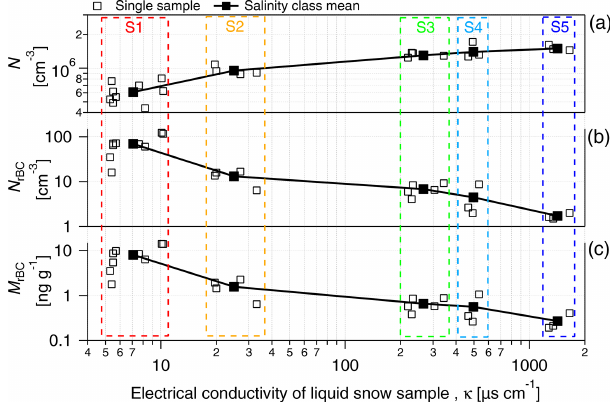
Figure 2. (a) The number concentration of the total particles ( N ), (b) number concentration of rBC particles ( N rBC ) and (c) mass mix- ing ratio ( M rBC ) produced from the nebulization of PASCAL snow samples as a function of the electrical conductivity of melted snow samples. Boxes indicate the salinity classes (Sn). N is measured with the SPMS in the 14–680nm diameter range. rBC particles are measured with the SP2 in the 70–1000nm diameter range. S1, S2, S3, S4 and S5 represent the salinity